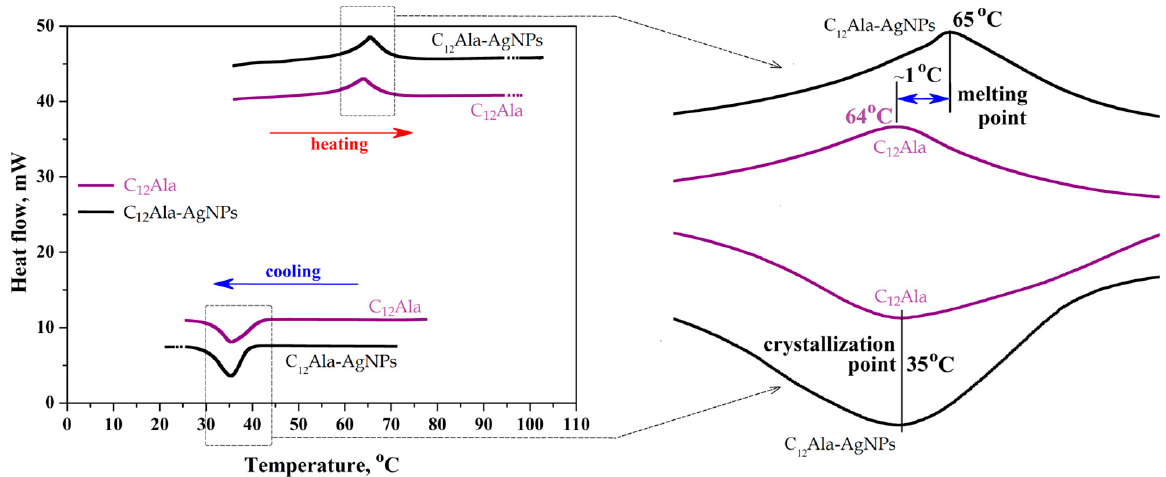
Figure 7. The second cycle (heating and cooling) of DSC measurements of C 12 Ala and C 12 Ala-AgNPs gel samples.